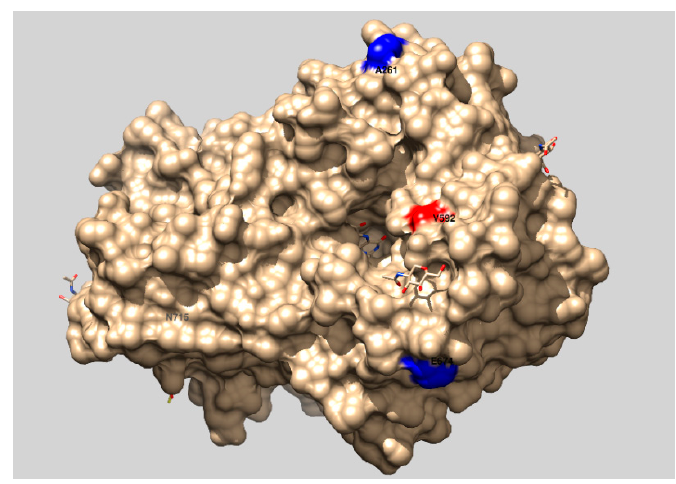
Figure 8. Presentation of the structure of the FAD domain of CDH from P.chrysosporium (PDB accession code 1NAA) with labelled substitutions. The picture was made with UCSF Chimera 1.13.1. (University of California, San Francisco, CA, US).